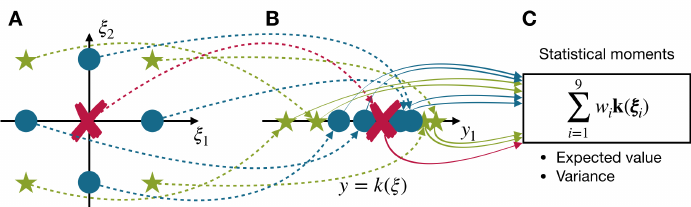
Figure 2. Illustration of the point estimation method (PEM) for a nonlinear function y = k ( ξ ) that has ( A ) two random inputs; ( B ) one model output y 1 ; and ( C ) the resulting approximations of statistical moments of y 1